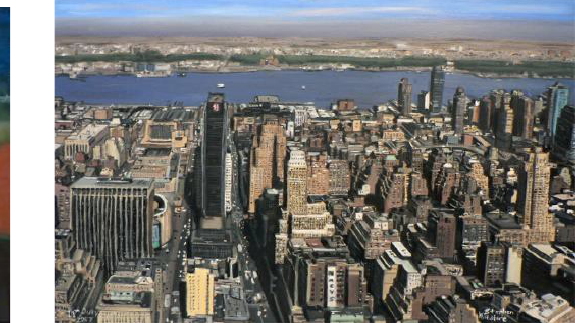
canvas 765 × 573 cm